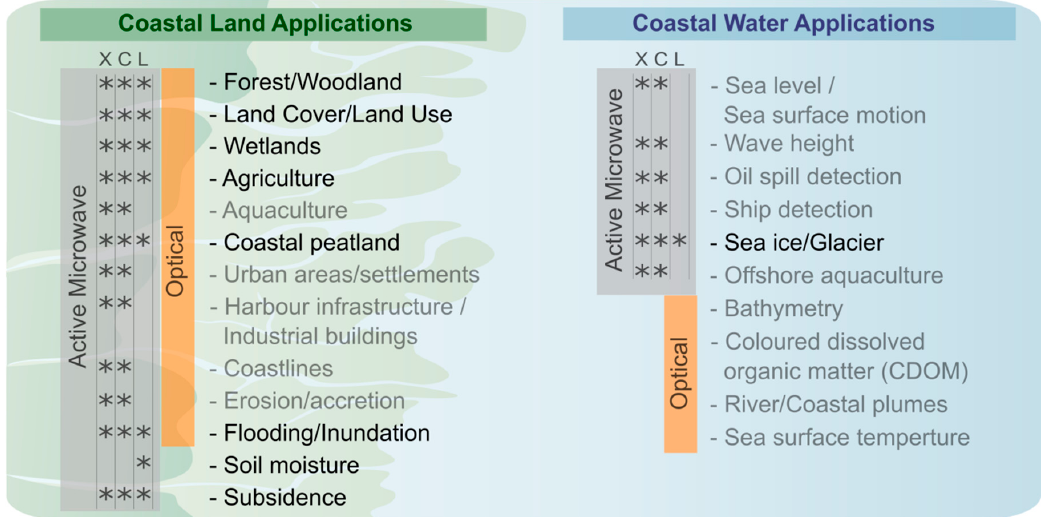
Figure 2. Remote sensing of coastal environments for various land- and water-related applications. The boxes on the left side of the listings indicate the suitability of active microwave (for X-, C-, and L-band SAR, see asterisk symbol) and optical data for the different coastal applications. The categories in bold text in the listings are relevant to L-band.